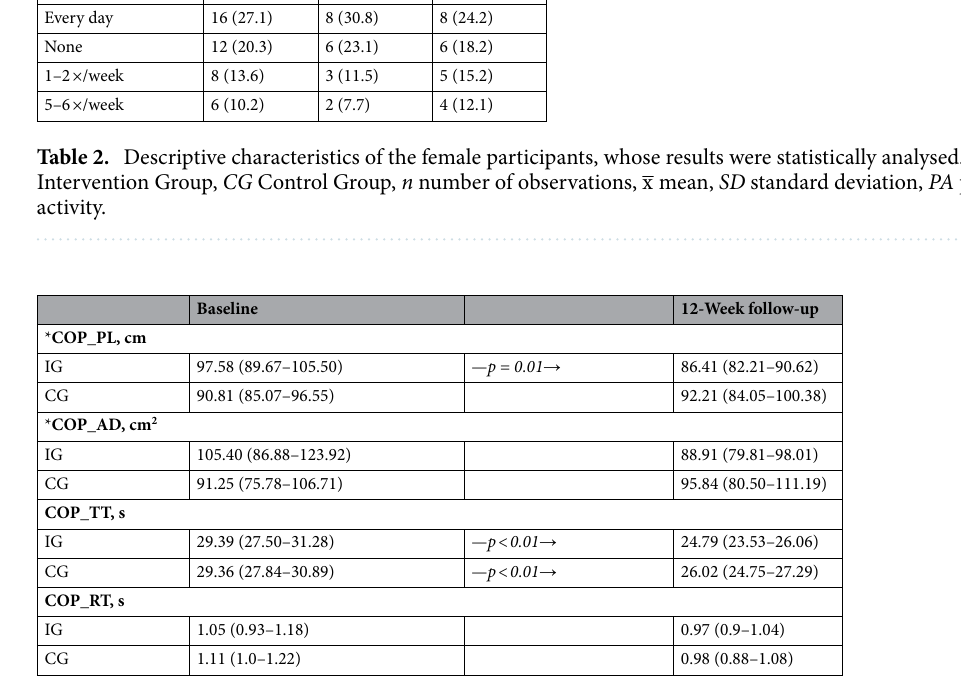
Table 3. Descriptive data—means and 95% confidence interval (CI) of COP_PL (cm), COP_AD (cm 2 ), COP_ TT (s) and COP_RT (s) at the baseline and at the 12-week follow-up in both intervention and control group. COP_PL path length of the centre of pressure, COP_AD area deviation of the centre of pressure, COP_TT total time of the centre of pressure activity, COP_RT reaction time of the centre of pressure, IG Intervention Group, CG Control Group. Test marked with *—there was significant interaction (p < 0.05) between group and measurement session (Group × Time interaction). Differences within group between baseline and 12-week follow-up are indicated as p